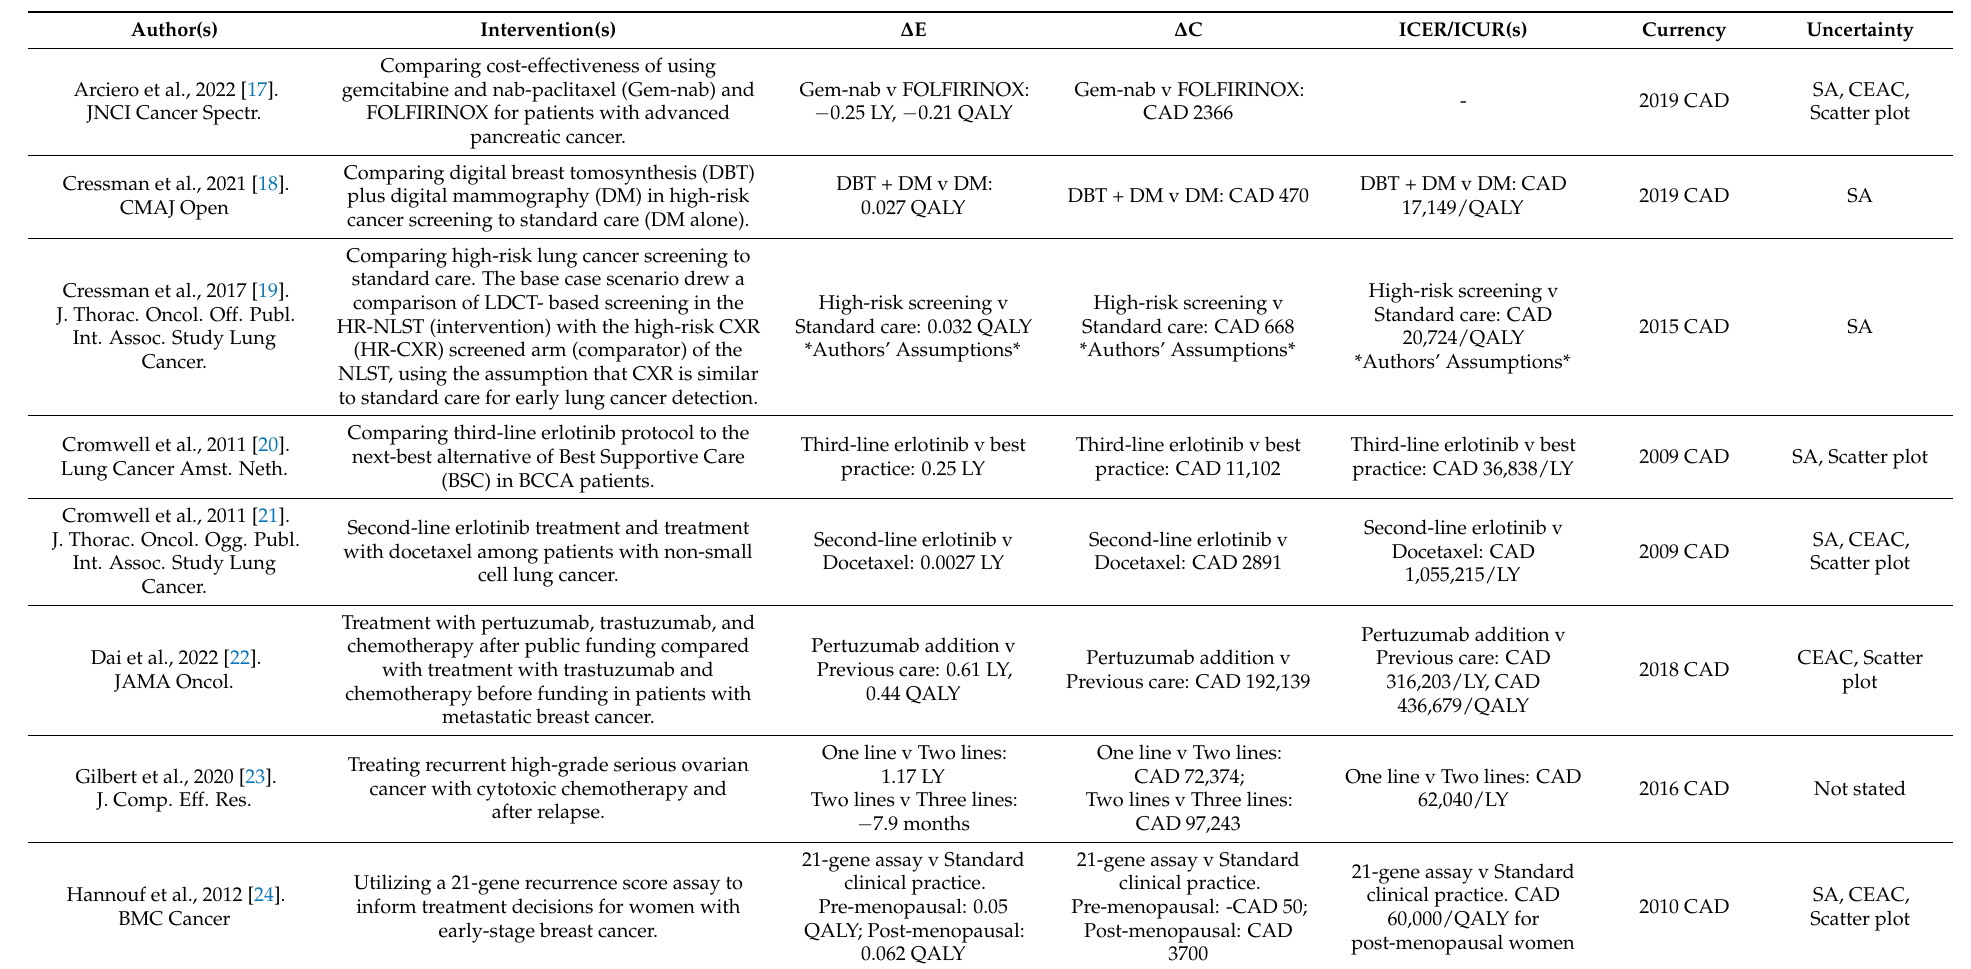
Table 3. Results of